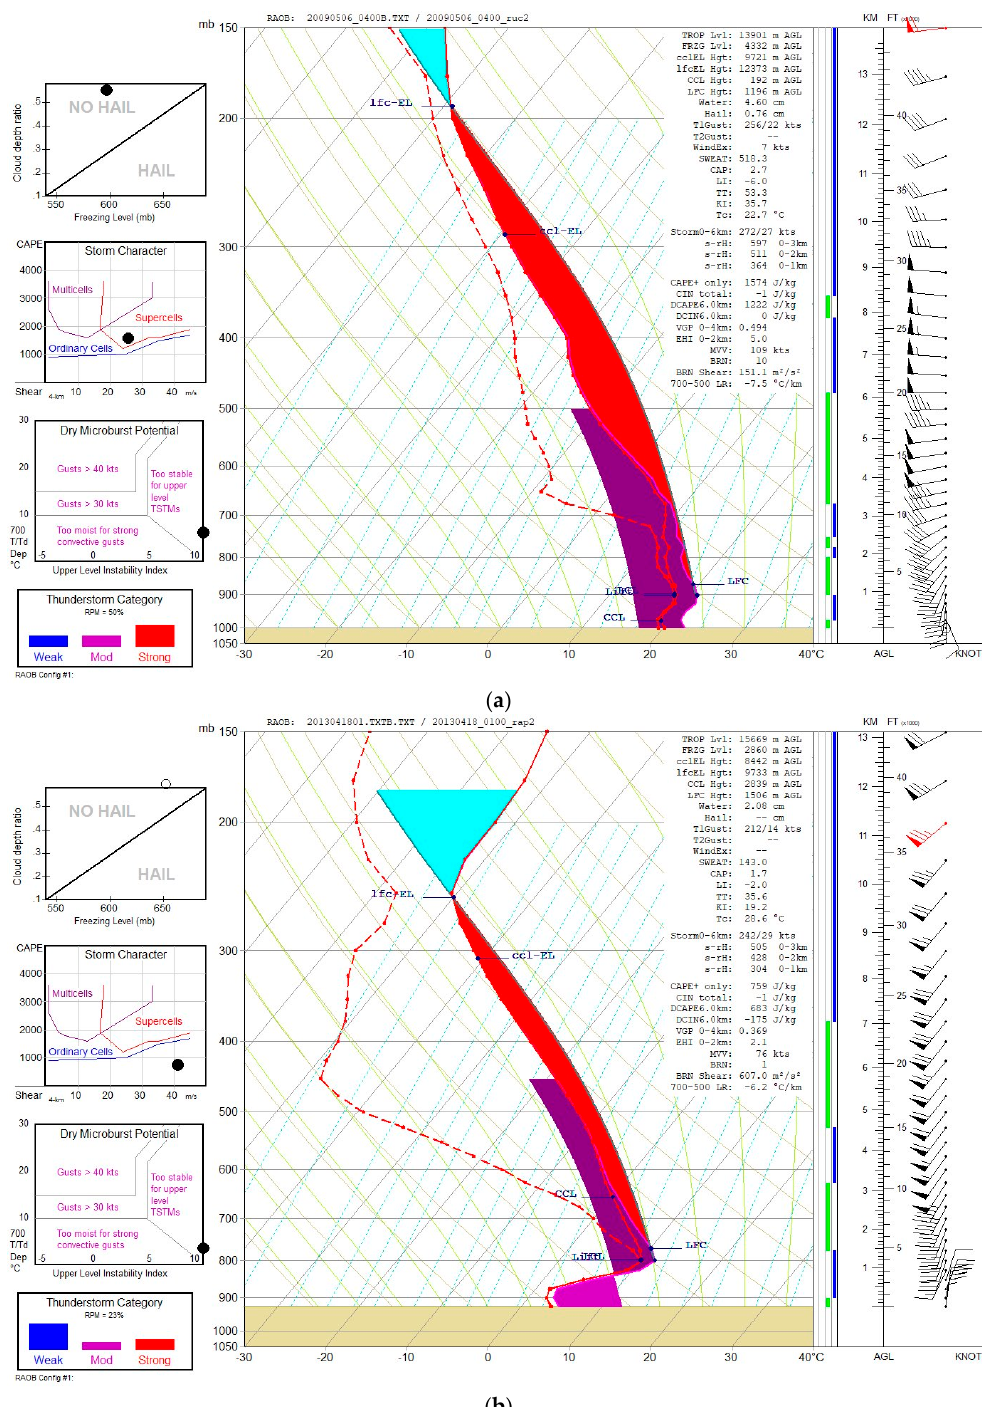
Figure 4. Examples of typical sounding plots for ( a ) a Prolific and Wind-Dominant case, and ( b ) a Marginal and Wind-Dominant case. CAPE (CIN) is shaded in red (cyan); and calculated with the virtual temperature correction. Downdraft convective available potential energy (DCAPE) is shaded as dark purple in both ( a ) and ( b ), whereas the downdraft convective inhibition (DCIN) is shaded as a light purple near the surface only in ( b ).